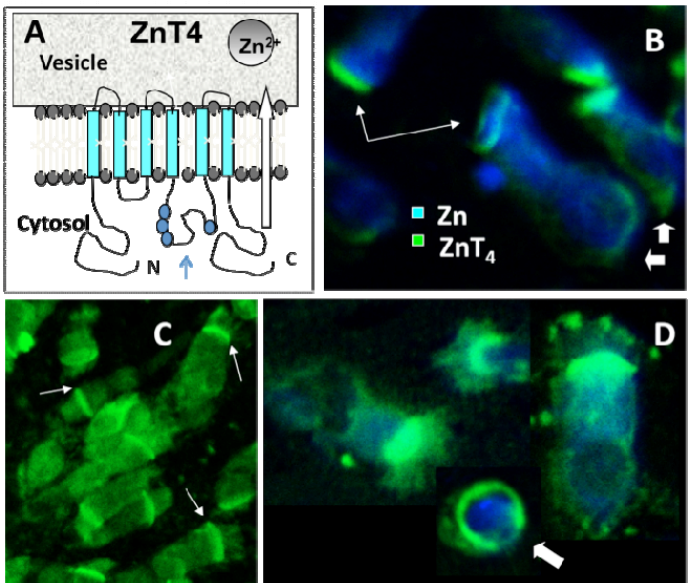
Figure 4. Localization of vesicular Zn transporter ZnT4 in primary human airway epithelial cells (AEC) by immunofluorescence ( A ) ZnT4 with 6 putative trans-membrane domains penetrates the membranes of cytoplasmic endosomes, vesicles and secretory granules with both N - and C -terminal ends and the histidine-rich loop, thought to bind cytosolic Zn, protruding into the cytosol; the large arrow shows the presumed direction of Zn movement out of the cytosol and into the vesicle; ( B – D ) Immunofluorescence labeling of ZnT4 (green) in human bronchial epithelial cells showing a tight band of fluorescence in the far apical cytoplasm and in the cilia as well as occasional staining of basolateral membrane (B and C) and of the entire membrane in a non-columnar cell (arrow in D). Blue labeling in panels B and D depicts Zinquin fluorescence of dual-labeled human bronchial epithelial cells. The more diffuse blue staining of Zn ions is due to effects of fixative on subsequent Zinquin staining. Merged confocal images are shown. Thin arrows in B and C point to the apical staining while thick arrows in B point to the basal